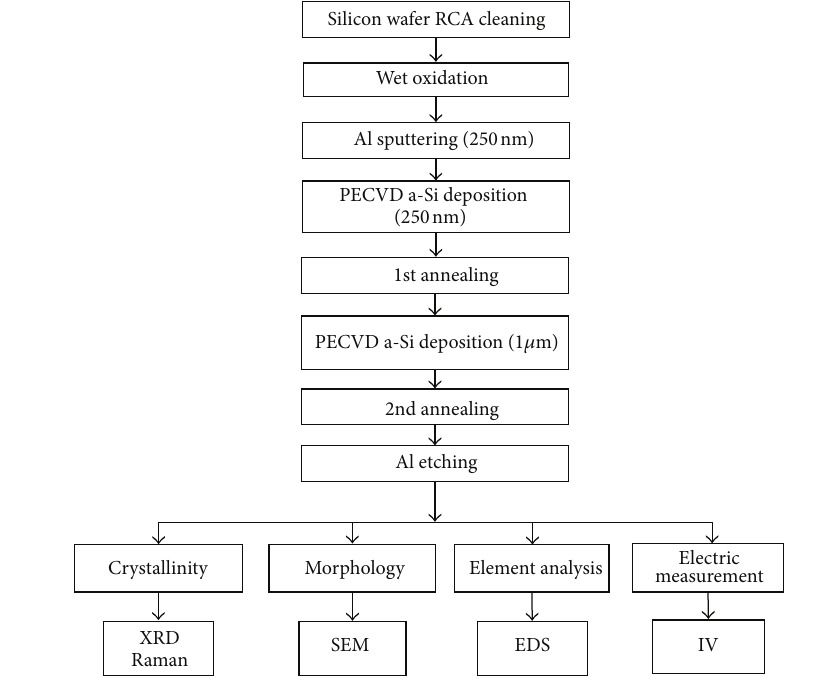
Figure 1: Flow chart of experimental procedure.